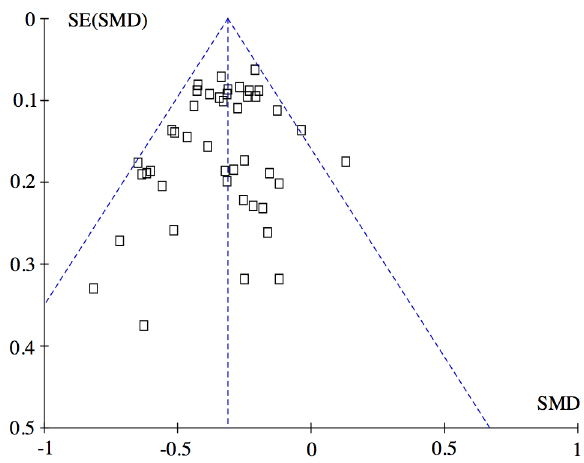
Figure 11. Funnel plot of all combination studies ([27] eliminated). The left lower corner is empty compared with the right lower corner. This asymmetry may indicate that small studies with no effect was not published (publication bias). However, this asymmetry is quantitatively small, and probably does not affect the overall result. Exclusion of the three lower right studies [18,19,44] to eliminate the asymmetry did not change the overall result shown in Figure 2: 2 0.31 SMD (CI: 2 0.35, 2 0.27), test for overall effect: Z=16.49 (P , 0.00001). Heterogeneity: Chi 2 =48.41, df=40 (P=0.17); I 2 =17%. Abbreviations: SMD: Standardized mean difference.